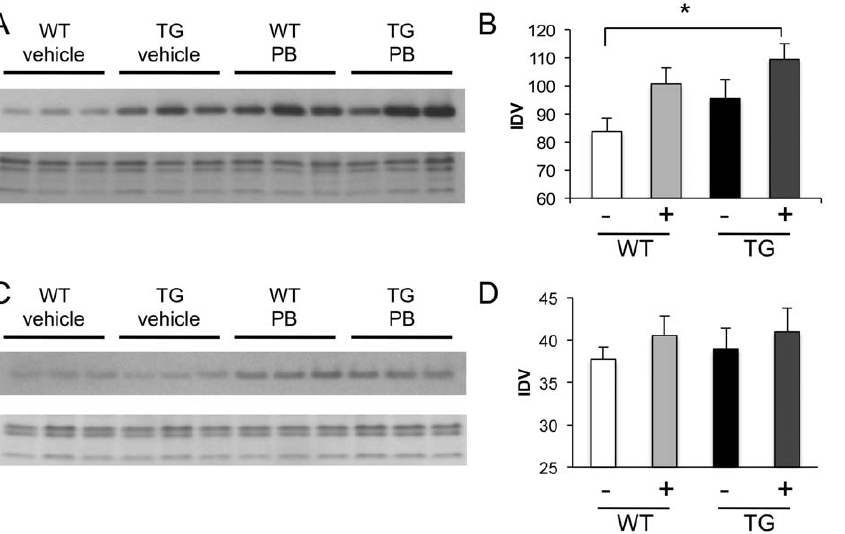
Figure 9. Phenylbutyrate treatment increases global histone H3 acetylation in R6/2 liver and cerebellum. (A) Western blot demonstrating AcH3 levels in histone extracts from WT and TG R6/2 livers (top), Coomassie blue gel staining demonstrates equal loading (bottom). (B) Integrated densitometry values (IDV) for AcH3 levels in A. (C) Western blot demonstrating AcH3 levels in histone extracts from WT and TG R6/2 cerebellum (top). Coomassie blue gel staining demonstrates equal loading (bottom). (D) Integrated densitometry values (IDV) for AcH3 levels in C. White bars, WT, vehicle (veh) treated (n=9); Light grey bars, WT, phenylbutyrate (PB) treated (n=8); Black bars, Tg, vehicle (veh) treated (n=7); Dark grey bars, Tg, phenylbutyrate (PB) treated (n=11). *, p-value , 0.05. Error bars are standard deviation.